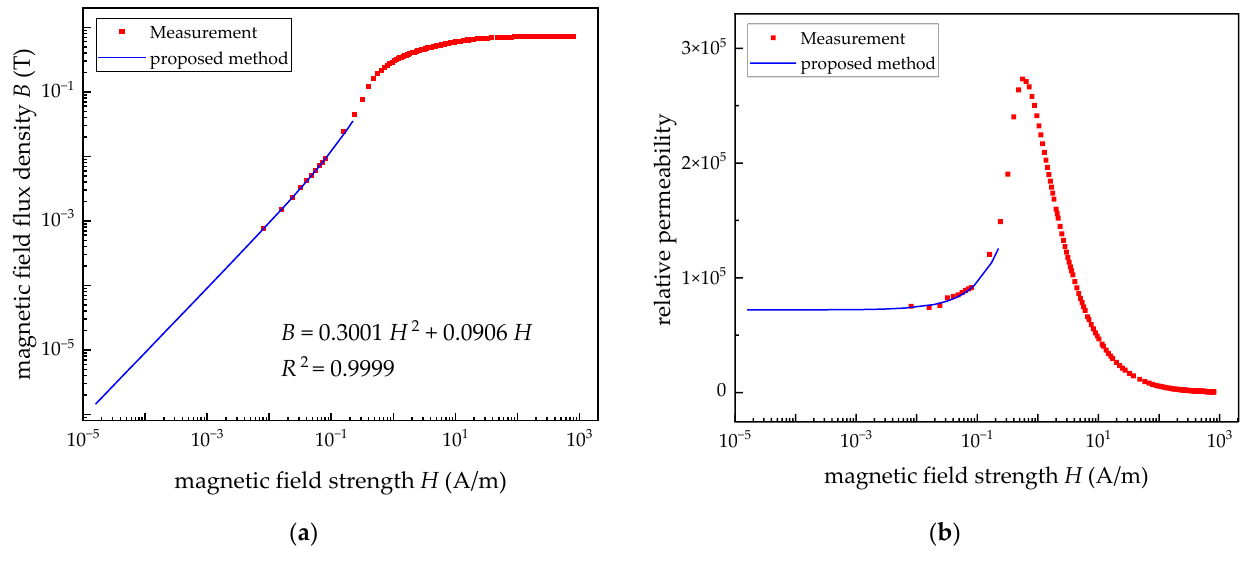
Figure 3. The comparison of the measurement and fitting curves. ( a ) The B - H curves. ( b ) The relative permeability curves.